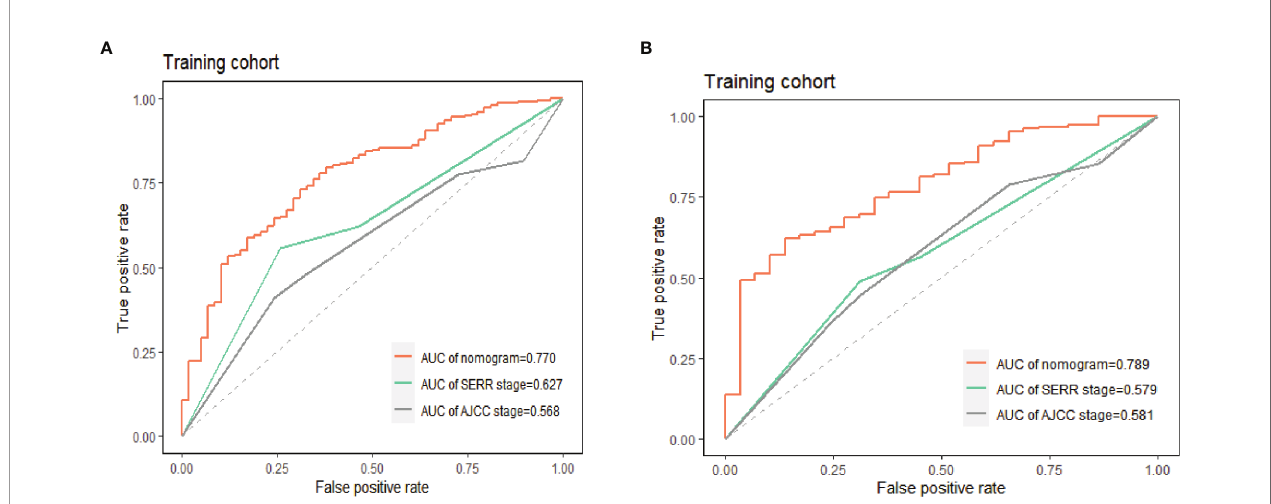
FIGURE 10 | Accuracy comparison of nomogram, AJCC.Stage, SEER.Stage in training group (A) and validation group (B) , AUC, area under the curve; ROC, receiver operating